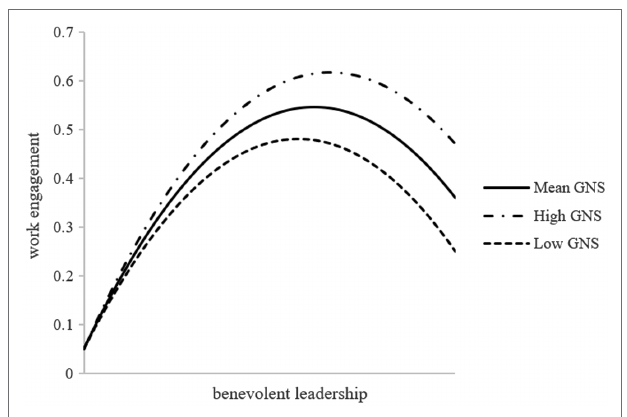
FIGURE 4 | The moderating effect of growth need strength on the relationship between benevolent leadership and employees’ work engagement at the individual level.